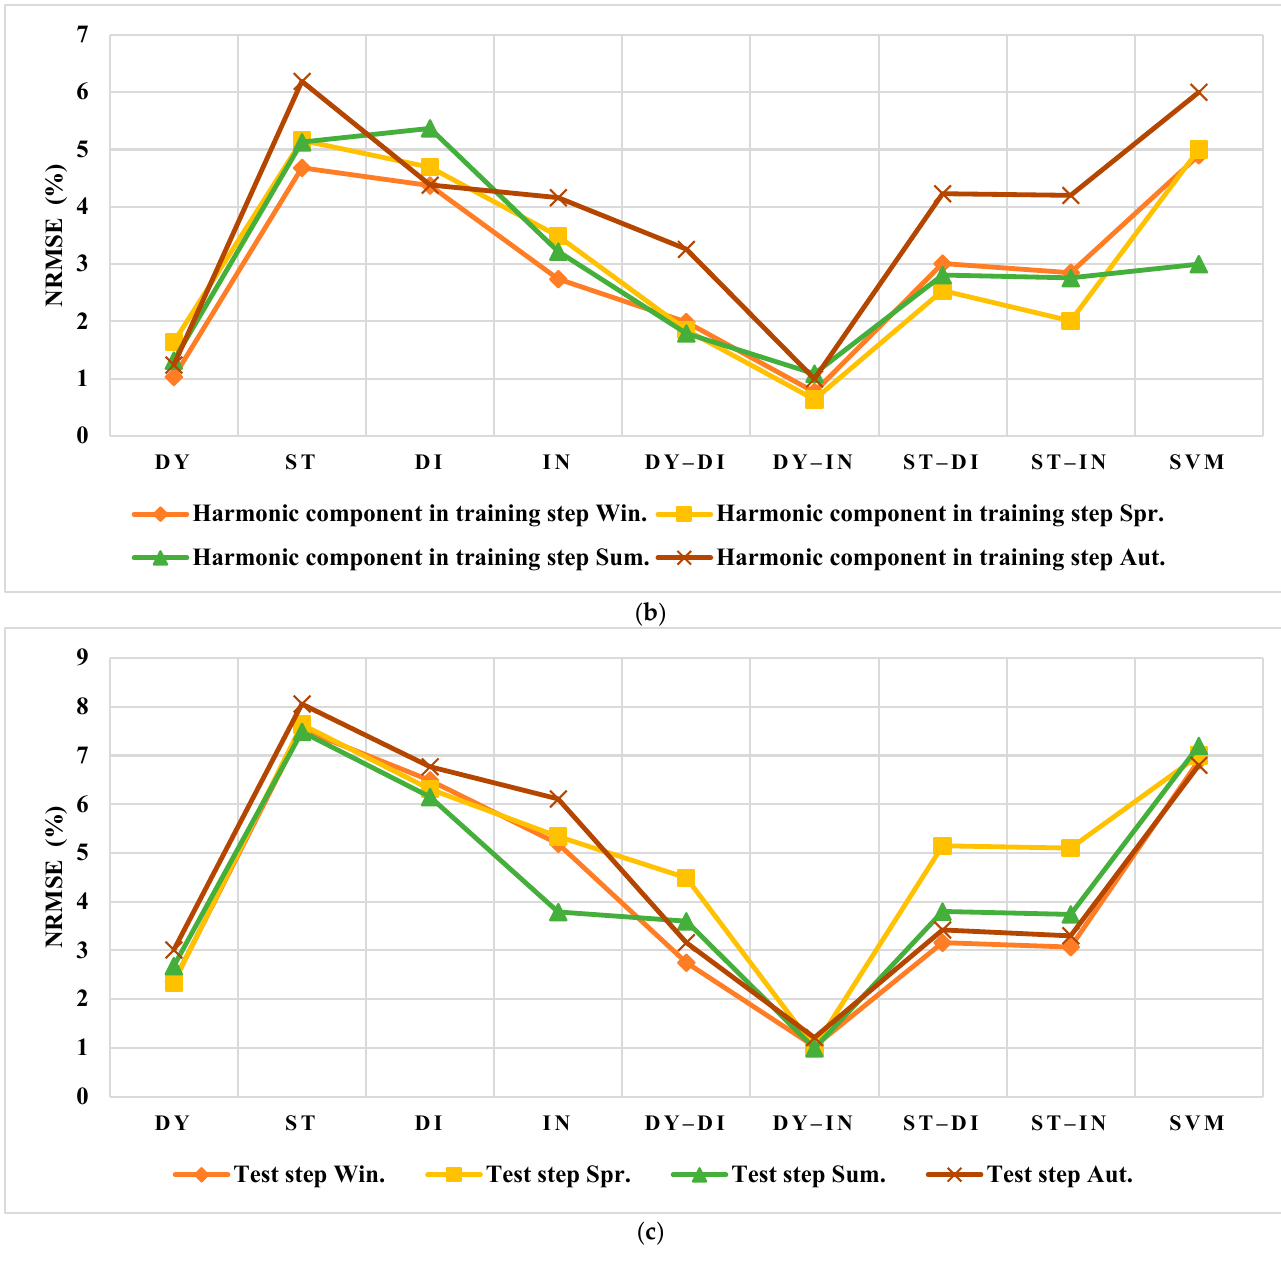
Figure 18. The results of NRMSE (%) for the US: ( a ) Main Component in training step, ( b ) Harmonic Component in training step, ( c ) Test step The best prediction accuracy with higher than 97% and a maximum of 99.99% is re- lated to the dynamic indirect GP that is shown in Figure 19. However, other combination methods have similar results. Additionally, the dynamic GP could realize 95% prediction of test data on average.